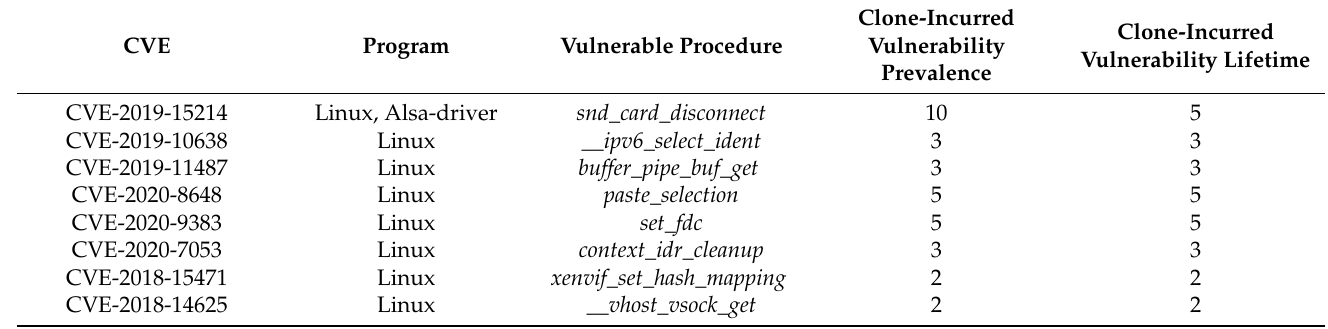
Table 3. Examples of clone-incurred